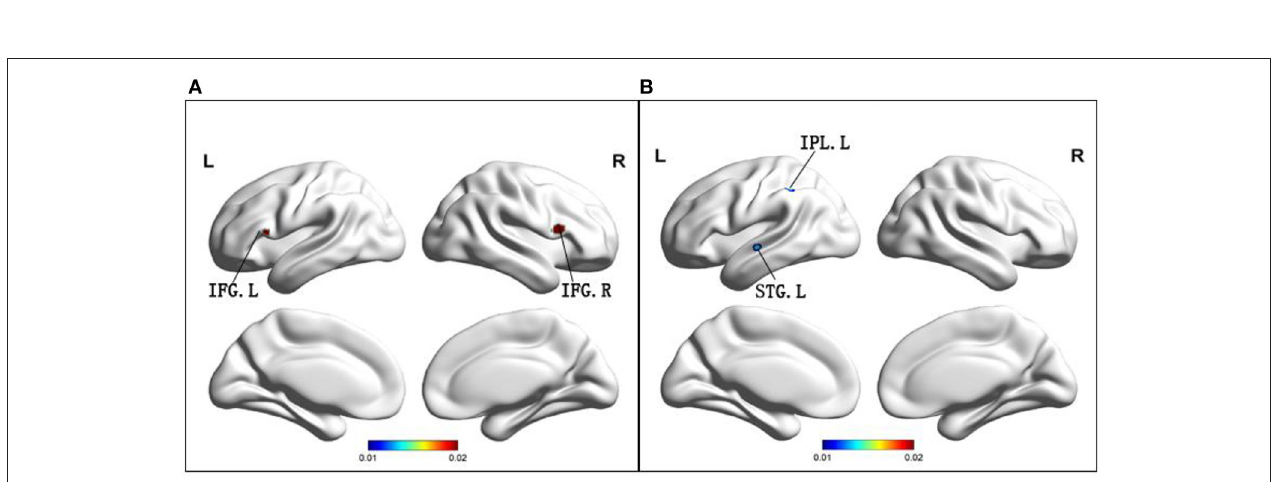
FIGURE 3 | (A) Brain regions showing increased ReHo in MCI patients compared to HCs. (B) Brain regions showing decreased ReHo in MCI patients compared to HCs. MCI, amnestic mild cognitive impairment; ReHo, regional homogeneity; HCs, healthy controls; IFG, inferior frontal gyrus; IPL, inferior parietal lobule; STG, superior temporal gyrus; R, right; L,